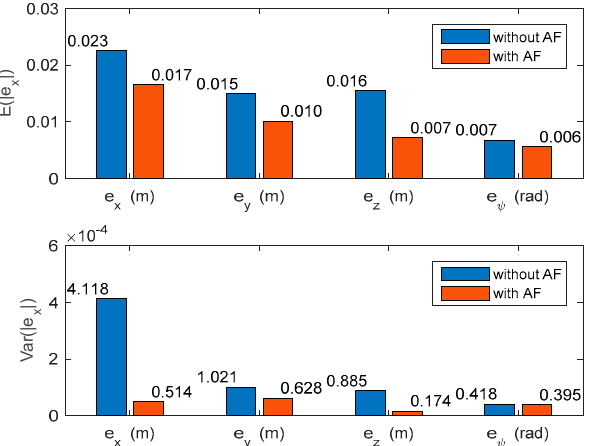
Figure 9. The mean and variance of absolute errors of the position and yaw angle of the hex-rotor controlled with and without the acceleration feedback enhanced term.